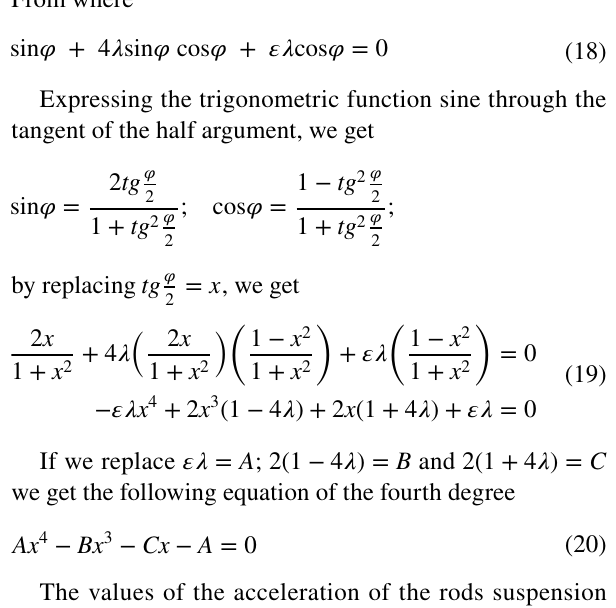
Fig. 3 The graphs of the acceleration of the rod suspension point on the angle of rotation of the crank ( 𝜑